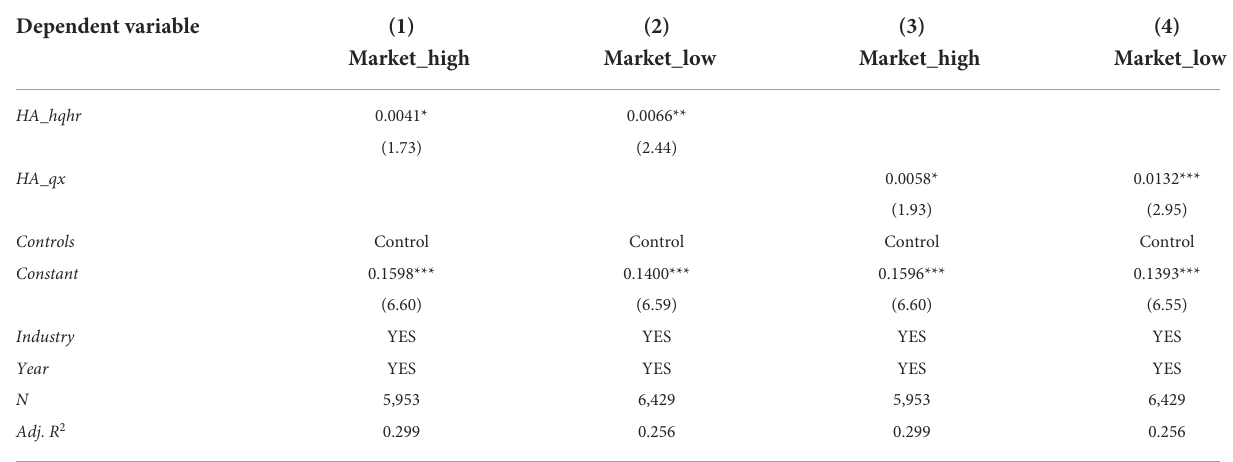
TABLE 8 The moderating effect of marketization